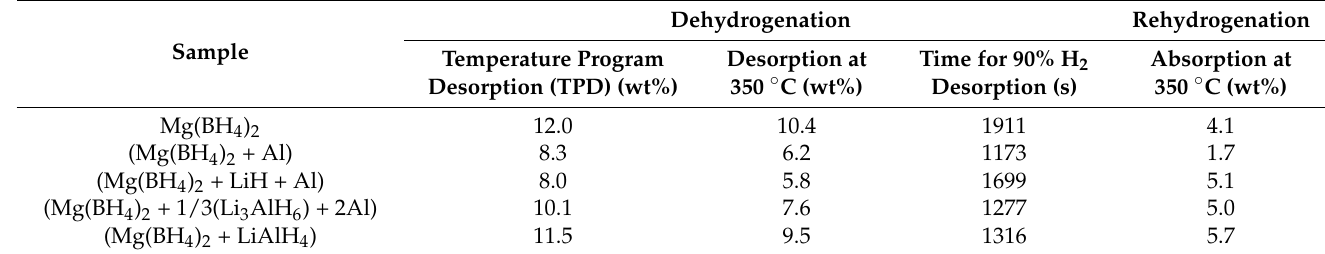
Table 3. Characteristics of hydrogen sorption from different samples [112].